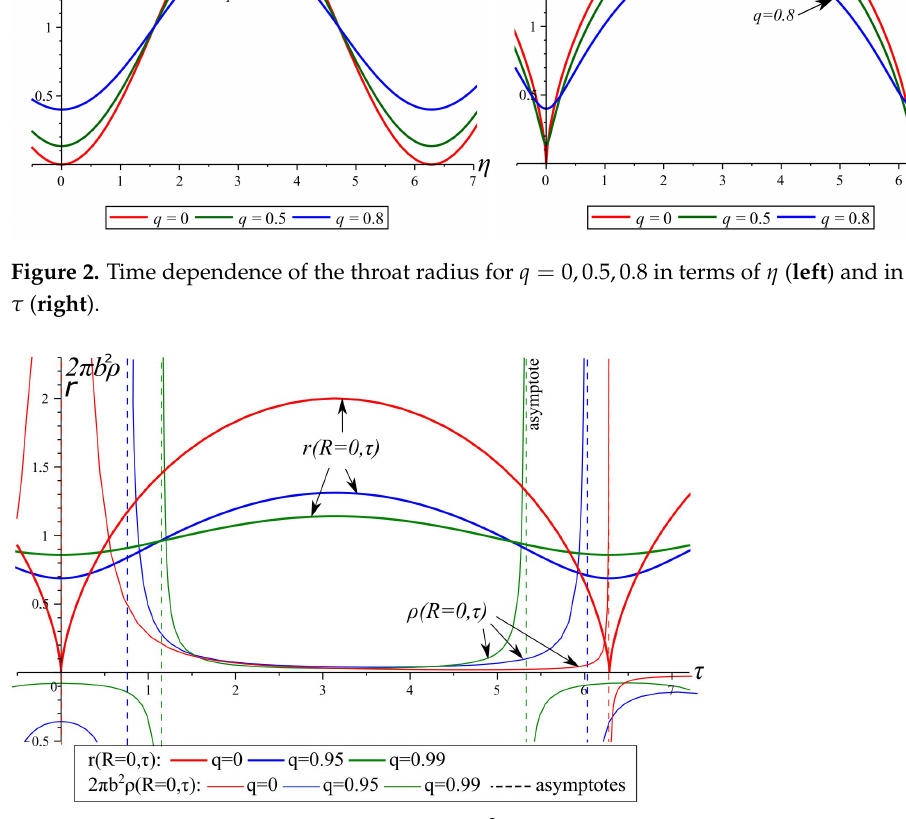
Figure 3. Time dependence of the functions 2 π b 2 ρ (thin lines) and r ( 0, τ ) (thick lines) on the throat R = 0 for q = 0, 0.95, 0.99 in the model (31). Dashed lines show the asymptotes. For other values of q the plots look in a similar